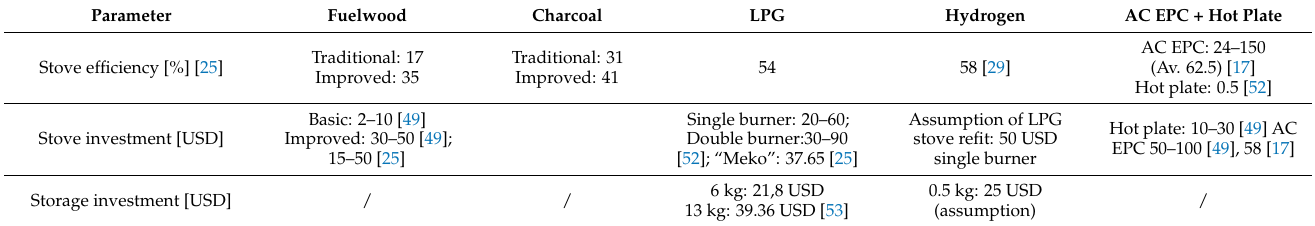
Table 3. Typical cooking stove parameter applied in this analysis. The annual fuel demand per household is calculated based on the simplified assumption that only one fuel is exclusively used as cooking fuel, neglecting fuel